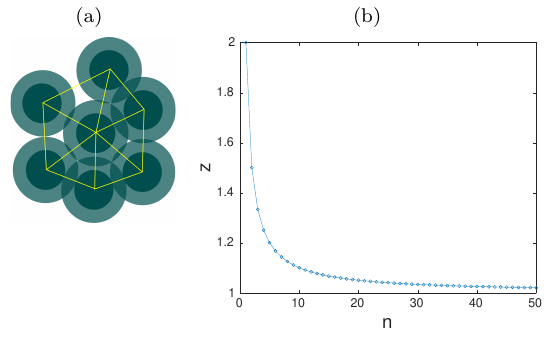
Figure 4: (a) Cell overlapping does not change the max- imum neighbor number of six; thus, the underlying lat- tice is topologically triangular (yellow lines). (b) The average neighbor number versus layer number quickly drops to one. At t = 50 days, n (cid:39) 50, N (cid:39) 4000 and z = 1 . 02, which means p s = 0 . 92. Figure 5: Growth of the colony on a triangular lattice, starting from the center (black dot). Each layer is de- picted in a different color and contains three nodes with z = 3 and the remainder with z =